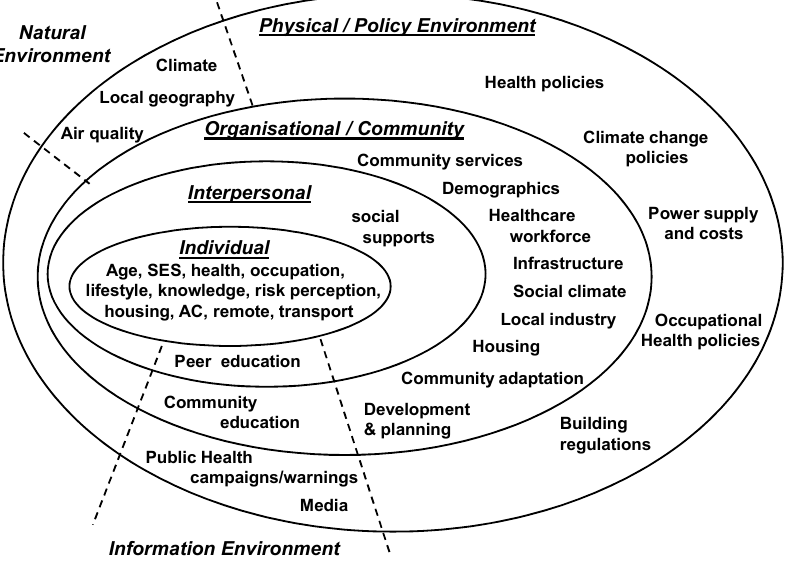
Figure 2. Factors affecting adaptation to extreme heat in rural communities within a socio-ecological